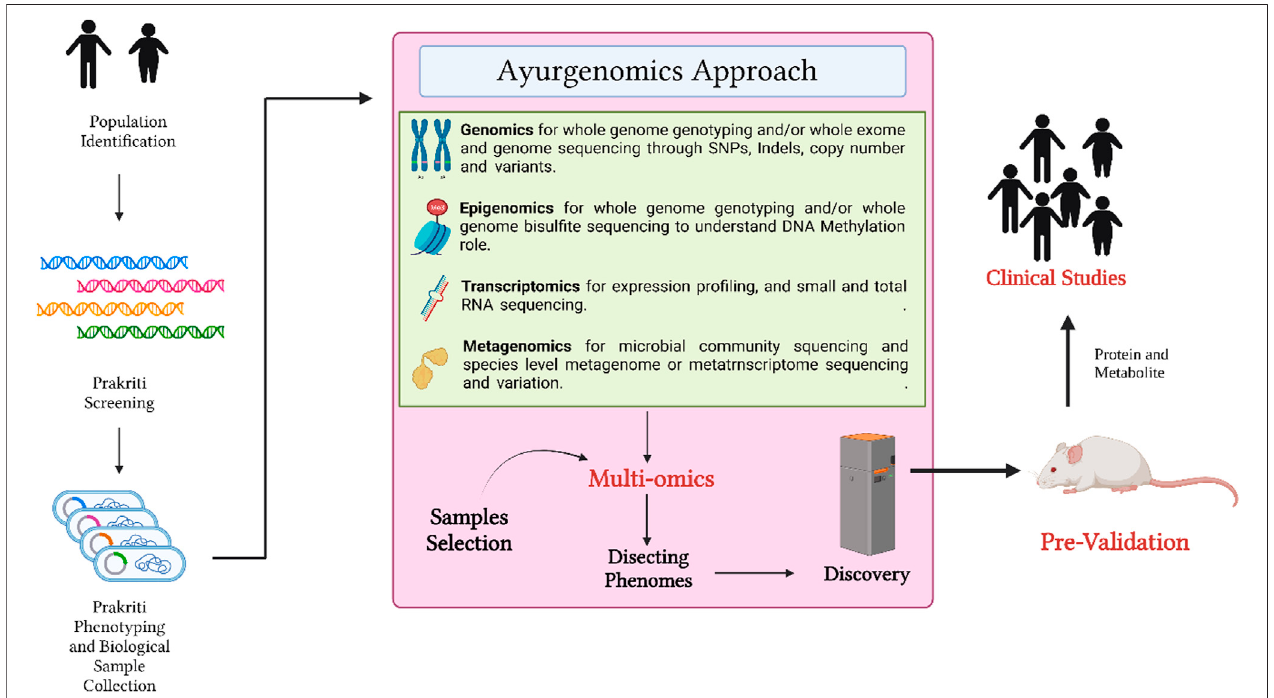
FIGURE 2 | Ayurgenomics approach for drug discovery towards personalized